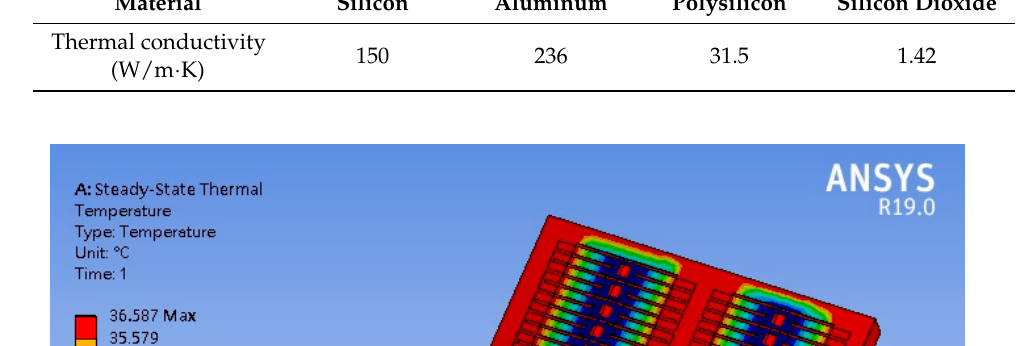
Figure 2. Computation of temperature distribution for the TEMH using the ANSYS. The thermoelectric energy micro harvester produces an output voltage, as it has a TD between the CHP of the thermocouples. The output voltage of the TEMH is given by [39],